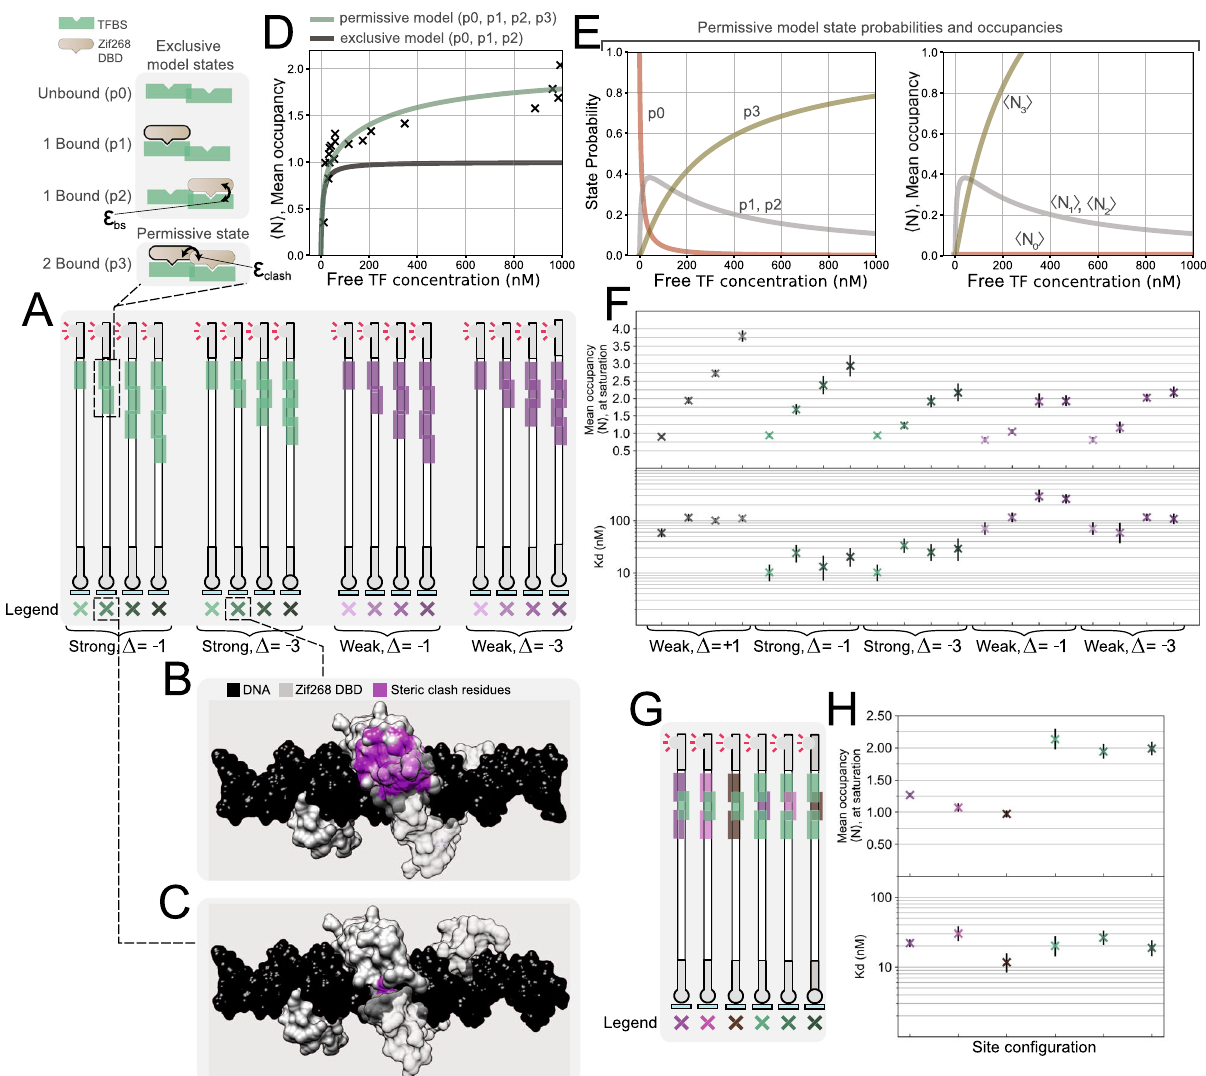
Fig. 4 | In vitro characterization ofhigh-density binding site clusters. A Library ofDNAtargetsanalyzedcontainingZif268highdensitybindingsiteclusters,where basepairsaresharedbetweenneighboringbindingsites.Clusterscontainuptofour strongorweakbindingsites,andneighboringsitesshare1or3commonbasepairs. B , C Aligned crystal structures, highlighting Zif268 residues expected to exhibit steric clash in magenta. 3 basepairs (33% of the Zif268 motif) shared in ( B ), and 1 basepair (11% of the motif) shared in ( C )). D , E Statistical mechanical analysis of binding to consensus binding sites sharing a common basepair. D , left Legend of the states corresponding to two different binding models, an exclusive binding model (top three states), and a permissive binding model (all four states). D , right Binding data and model predictions, illustrating that two transcription factors can